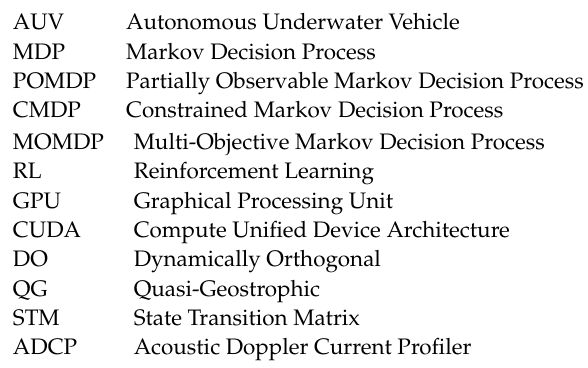
Table A1. Figures with trajectories and links to corresponding videos. Figure Number URL Figure 3A Figure 3B Figure 3C Figure 4B Figure 4C Figure 7A Figure 7B Figure